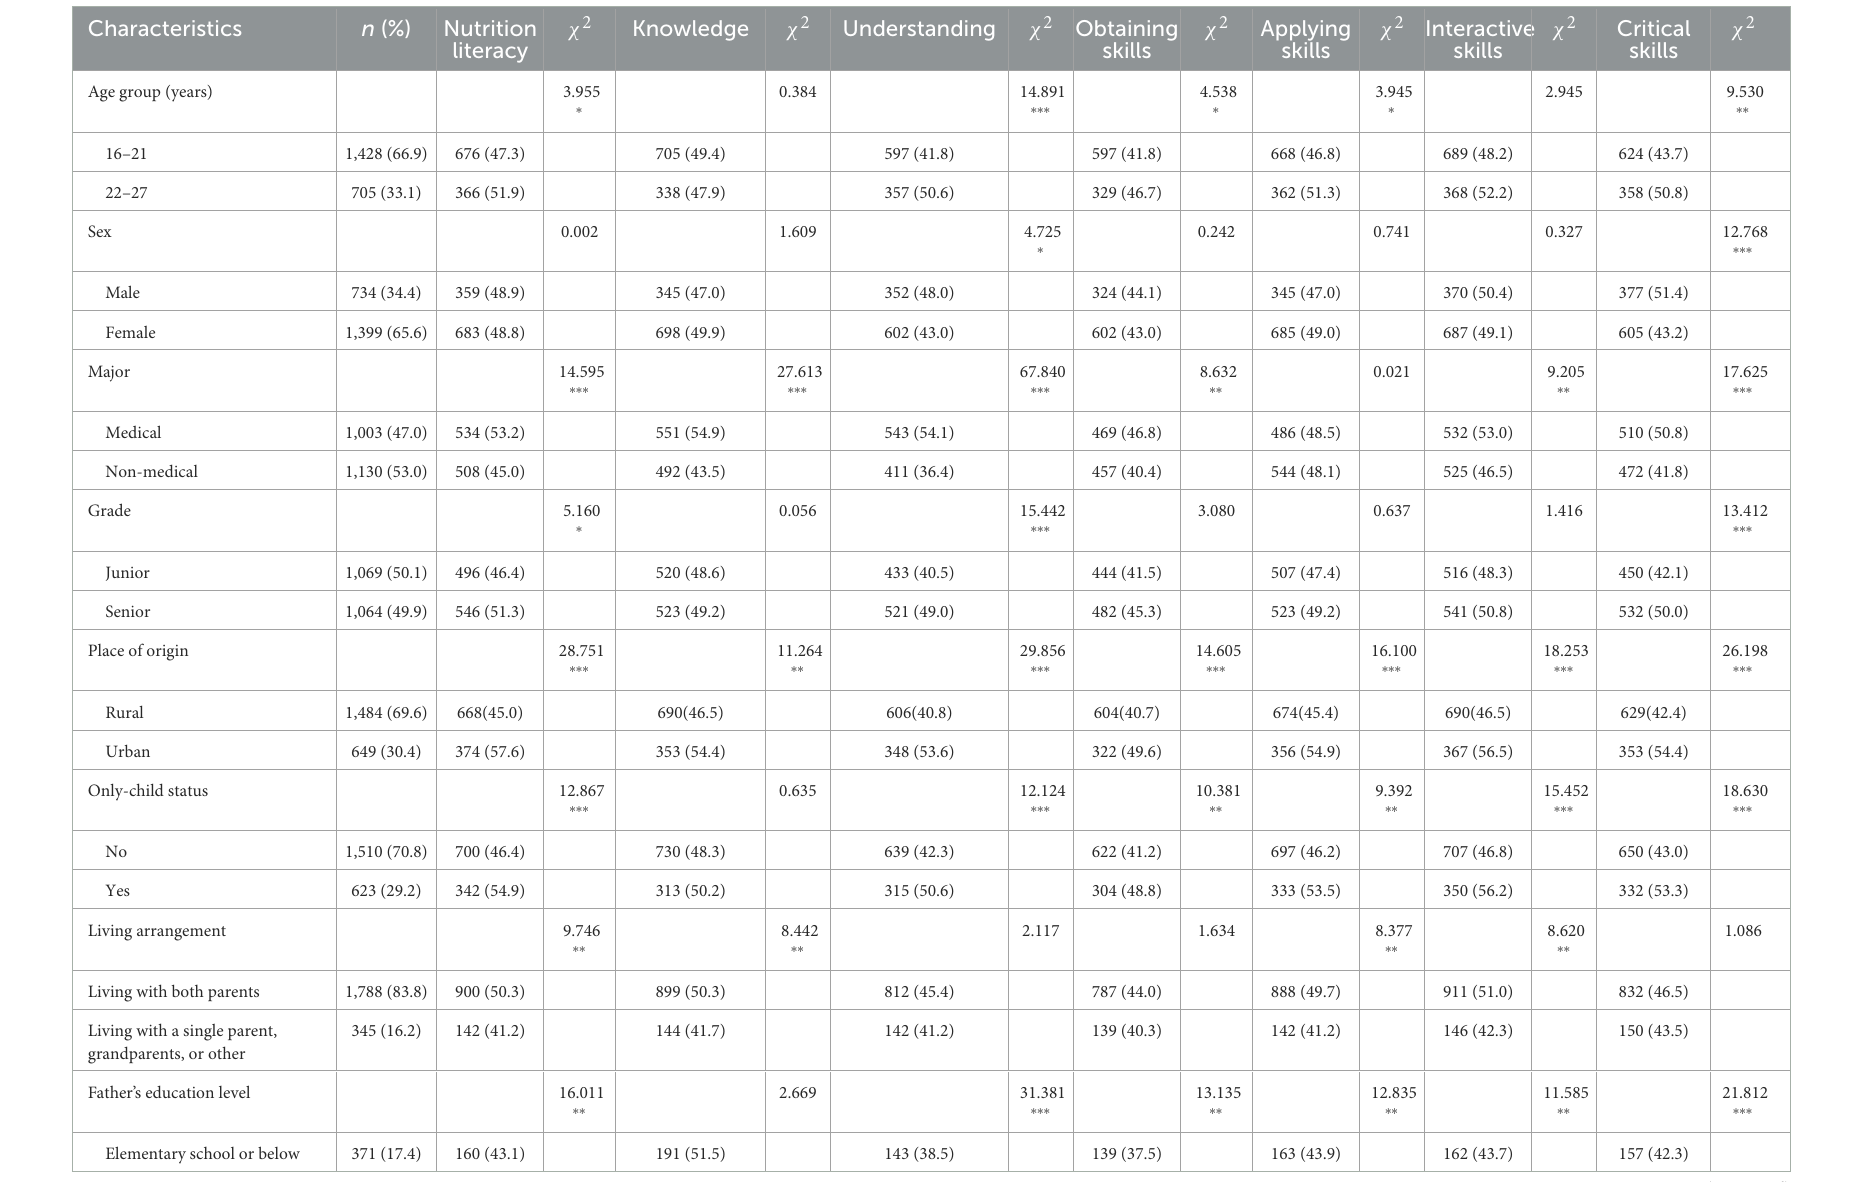
TABLE 1 Distribution of different characteristics by total nutrition literacy and its six dimensions.